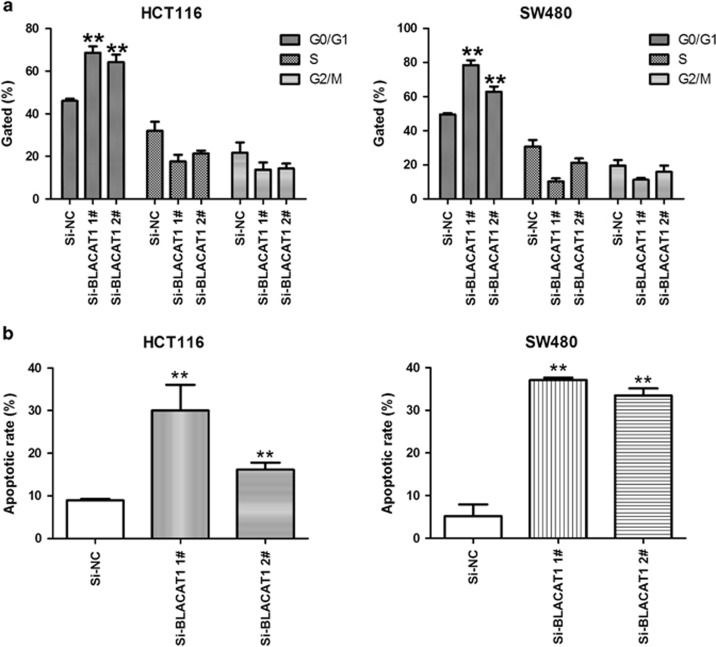
BLACAT1 is a regulator of gastric cancer cell cycle. (a) Flow cytometry showed that cell cycle arrest at the G1–G0 phase increased in both HCT116 and SW480 cells when BLACAT1 was repressed. (b) The results of apoptosis assays indicated that knockdown of BLACAT1 could obviously induce cell apoptosis. Error bars indicate means±S.E.M. **P<0.01